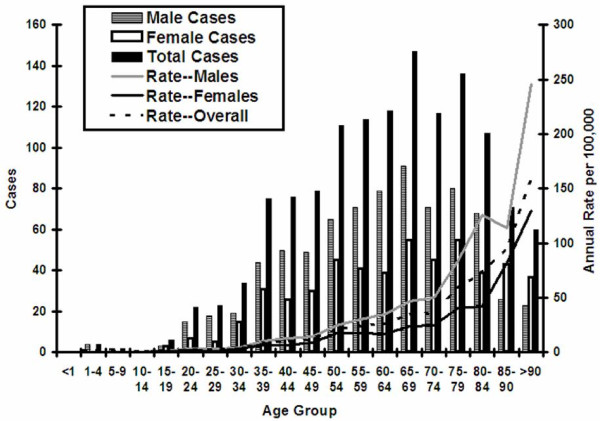
Trends in Legionnellosis Case Counts and Rates by Age and Sex, Ontario 1978 to 2006. A marked increase in case counts and disease rates is seen with increasing age. Diminished case counts in the oldest individuals (black bars) reflect small size of population at risk; rates increase continuously (dashed black line). Case counts in males (gray bars) are higher than those in females (white bars) in all but the oldest age groups. However, as fewer males survive to extreme old age, rates of disease per 100,000 population are higher in males (gray line) than in females (solid black line) in all age groups.